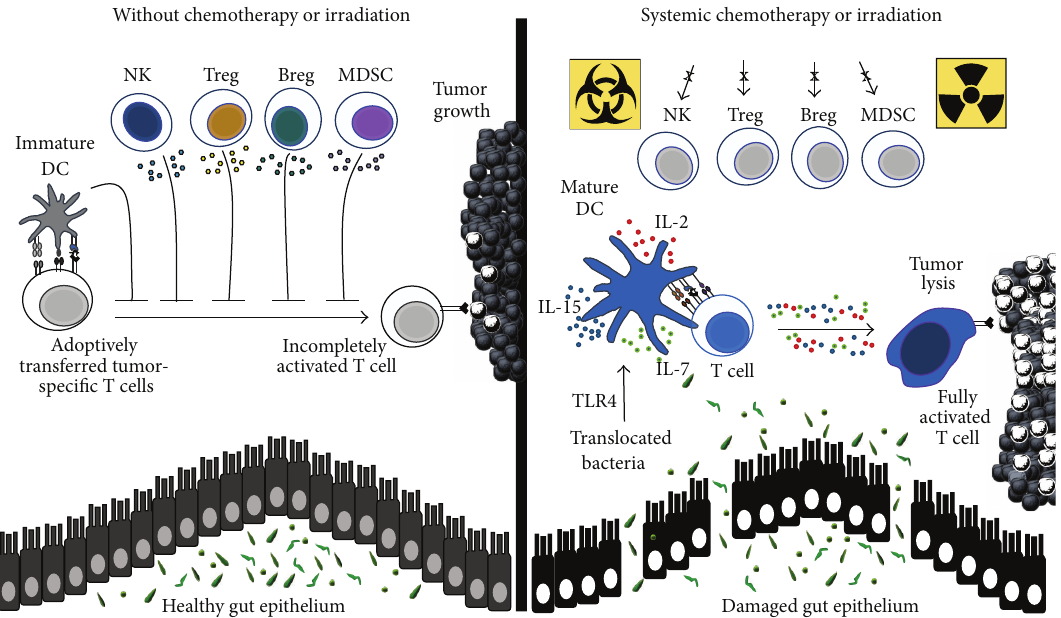
Figure 1: Lymphodepletion enhances the antitumor activity of transferred T cells. Left panel: without chemotherapy, natural killer (NK) cells act as cytokine sinks that compete for homeostatic cytokines (IL-7 and IL-15) that otherwise help transferred T cells engraft. Additionally, immune suppressive cells, such as regulatory B and T cells (Breg and Treg, resp.) and myeloid derived suppressor cells (MDSC), abrogate the function of transferred T cells. Right panel: lymphodepleting preparative regimens eliminate cytokine sinks and immune suppressive cells leading to enhanced function of transferred T cells. Furthermore, systemic chemotherapy or irradiation impairs gut homeostasis leading to the translocation of bacteria and by-products including LPS (TLR4 agonist). Immature dendritic cells (DC) are activated via TLR4 signaling, which in turn activate transferred T cells. Transferred T cells preferentially expand following the consumption of homeostatic cytokines produced by mature DCs, resulting in potent antitumor responses in vivo